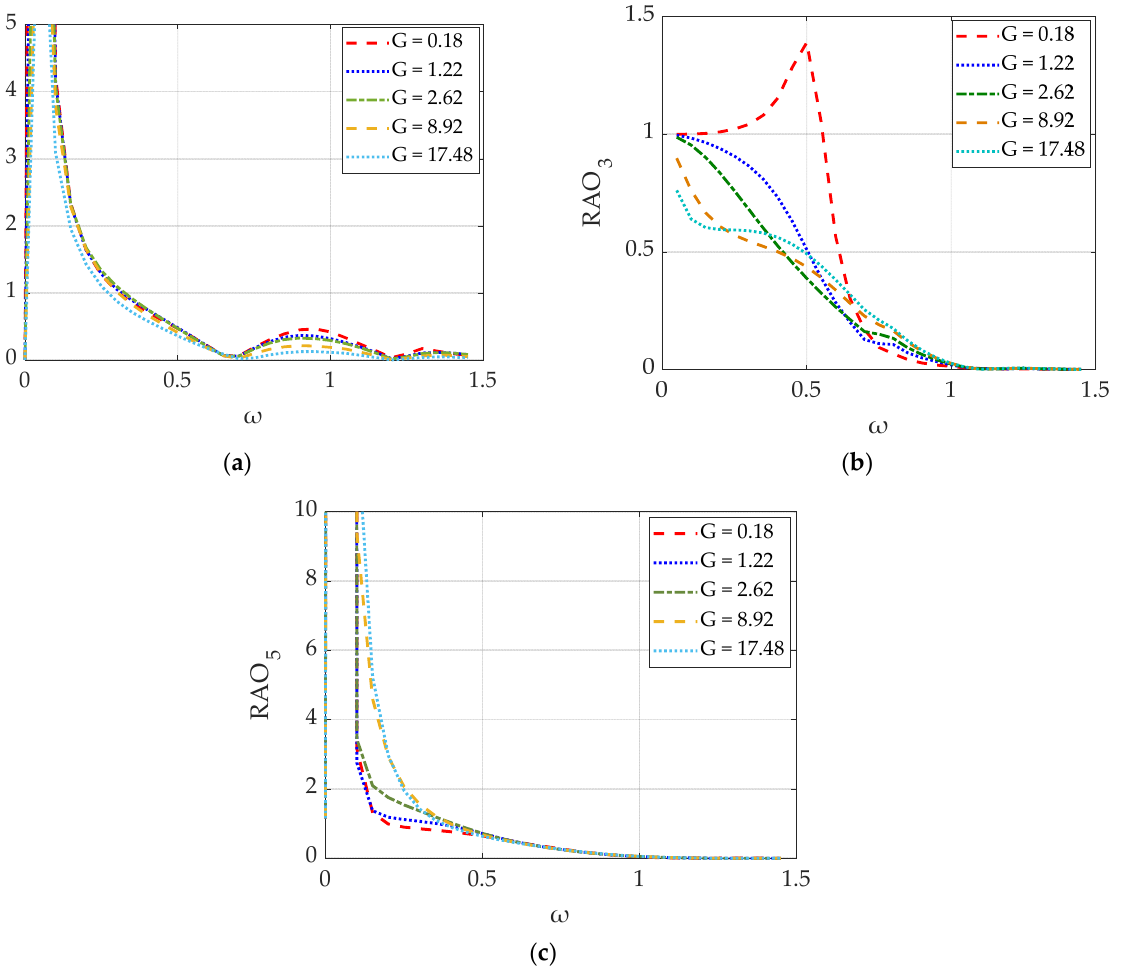
Figure 10. Dimensionless motions RAO 1 ,RAO 3 , RAO 5 of the permeable cylindrical body against wave frequency ω for various values of porous effect parameter G = 0.18, 1.22, 2.62, 8.92, and 17.48: ( a ) RAO 1 ; ( b ) RAO 3 ; ( c ) RAO 5 . Here, the dynamic mooring characteristics were taken into sideration.